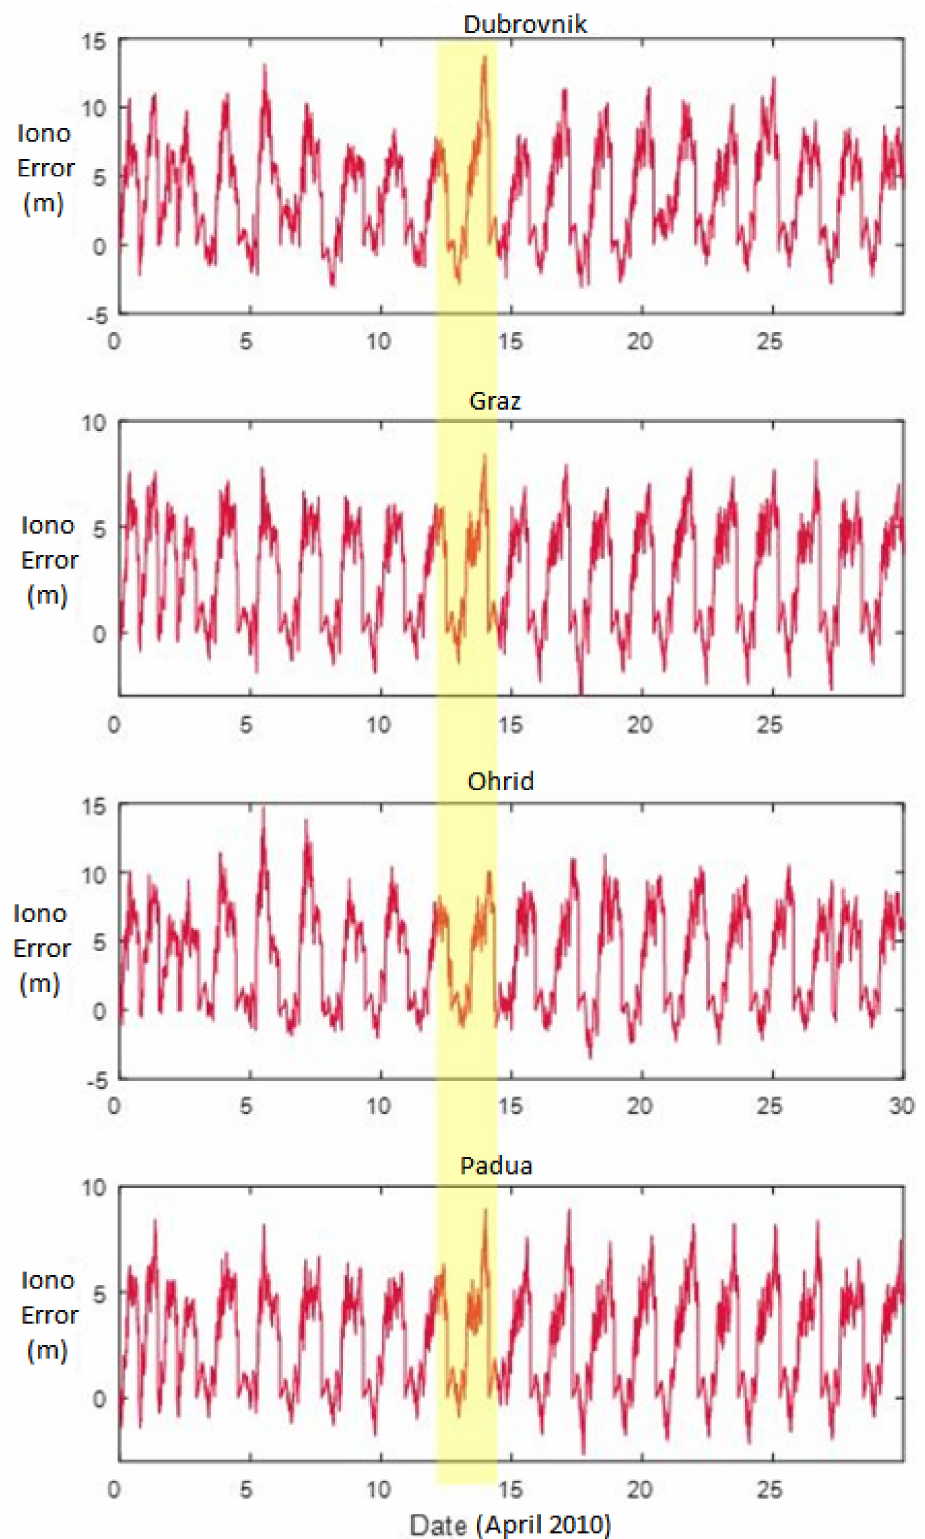
Figure 4. Time series of vertical TEC (VTEC) values, during days April 2010, as observed at reference